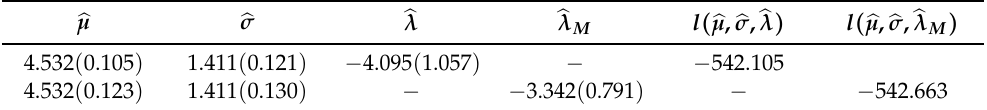
Table 5. MLEs of the µ , σ , λ , and λ M parameters.